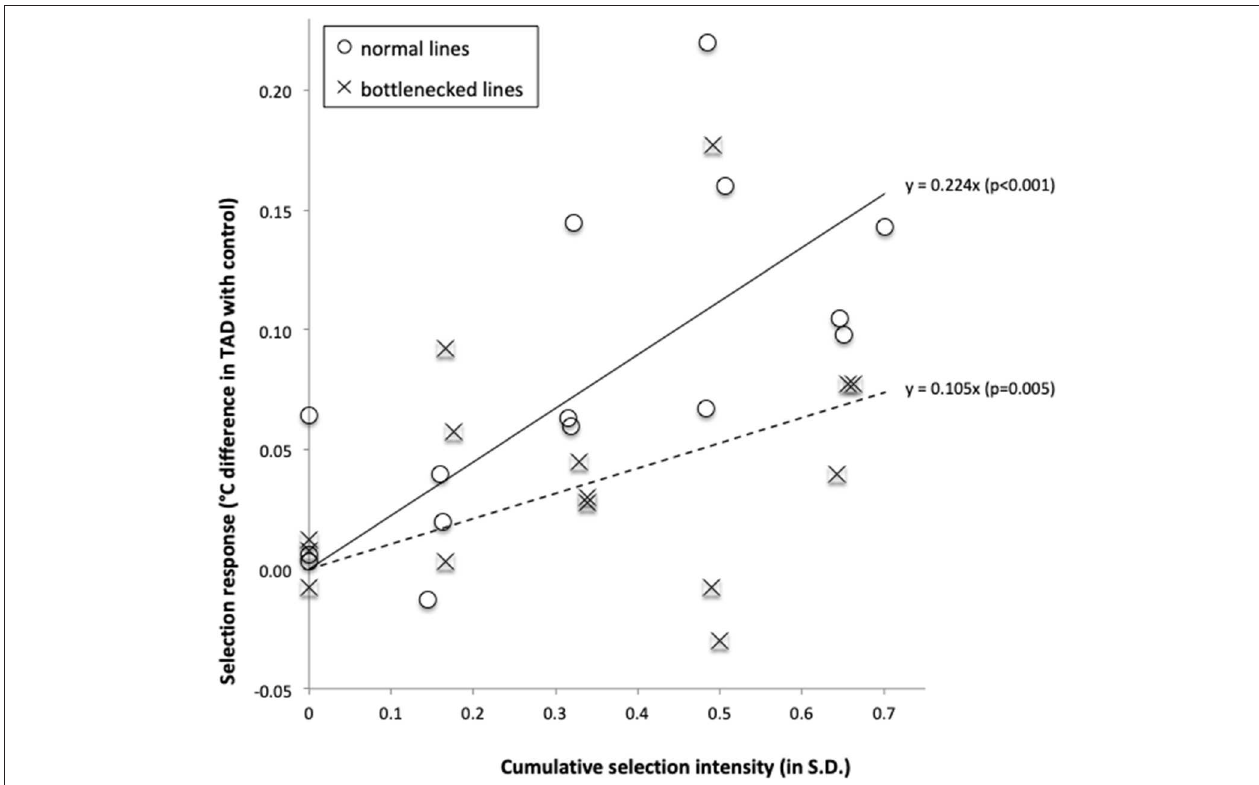
FIGURE 4 | Selection response (difference in temperature-at-death (TAD) between fish from a selection line and fish of its paired control line), as a function of the cumulative selection intensity. Data were grouped by source population type: normal populations (open circles, solid regression line) and bottlenecked populations (crosses, broken regression